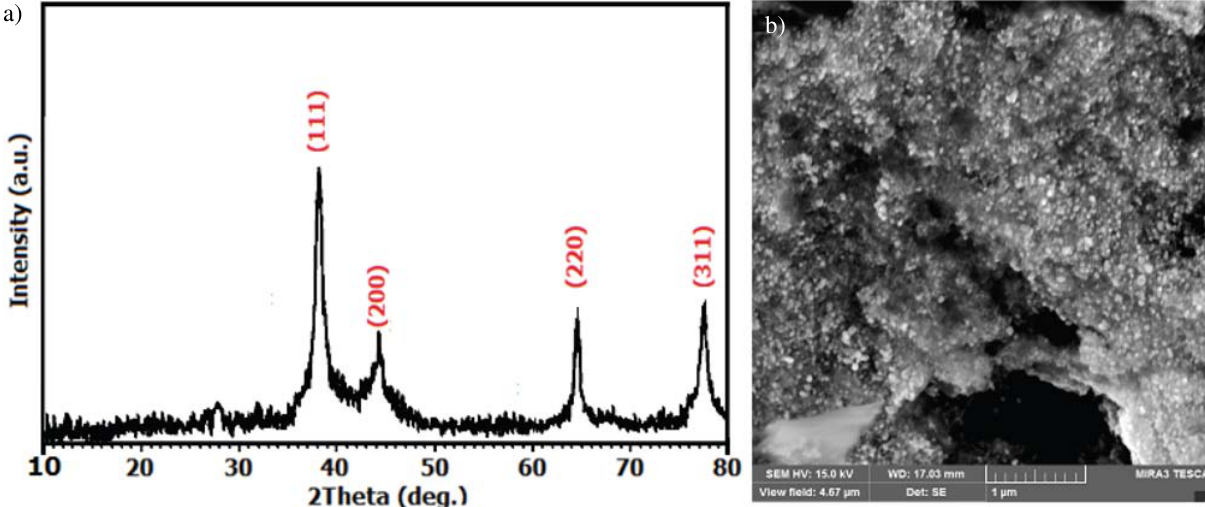
Fig. 13. (a) XRD pattern and (b) SEM image of the recovered Ag NPs after the fourth cycle.